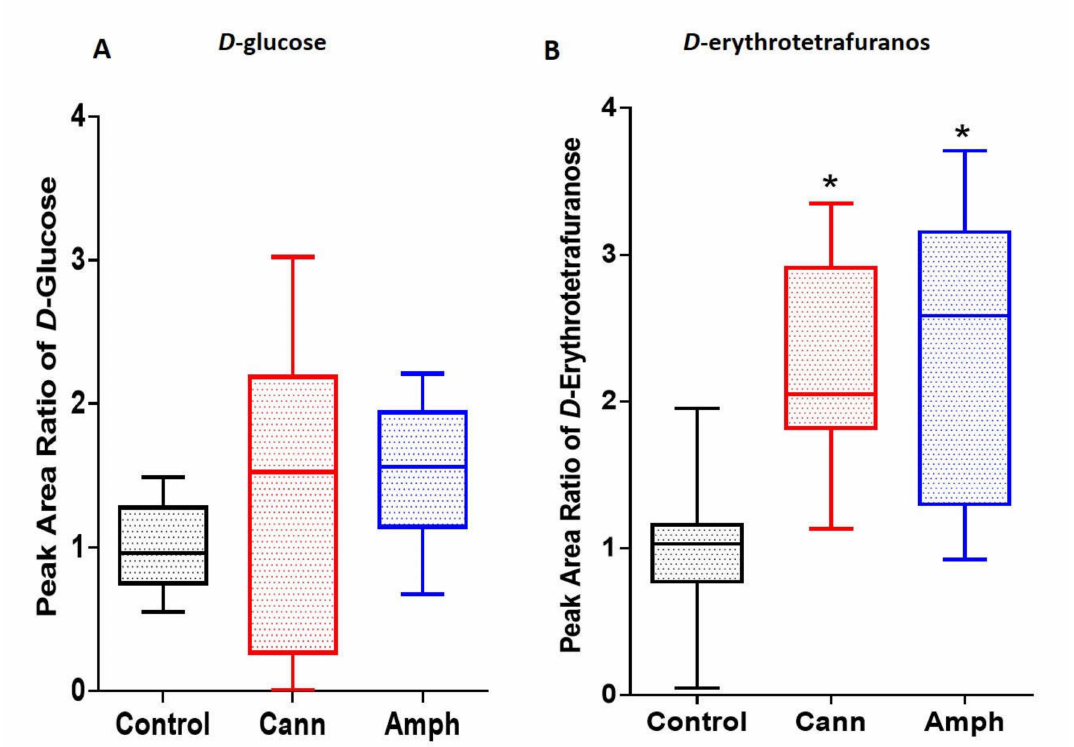
Figure 1. Effects of cannabis or amphetamine on selected sugars in cannabis or amphetamine use disorder patients. ( A ) Kruskal–Wallis test followed by Dunn’s multiple comparisons analysis